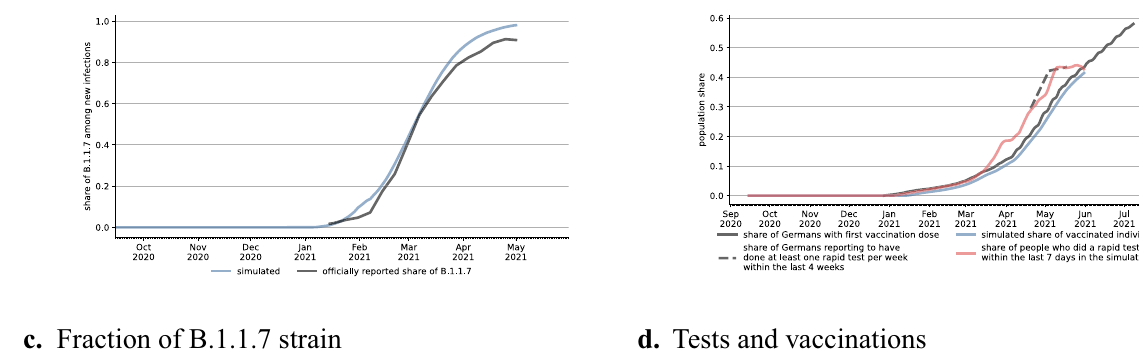
Figure 2. Evolution of the pandemic, its drivers, and model fit, September 2020 to May 2021: Data sources are described in Supplementary Material A. Age- and region-specific analogues to ( a ) can be found in Supplementary Material B.10. For legibility reasons, all lines in ( b ) are rolling 7-day averages. The Oxford Response Stringency Index is scaled as 2 · ( 1 − x / 100 ) , so that a value of one refers to the situation at the start of our sample period and zero means that all NPIs included in the index are turned on. The other lines in ( b ) show the product of the effect of contact reductions, increased hygiene regulations, and seasonality. See Appendix A.5 for separate plots of the three factors by contact